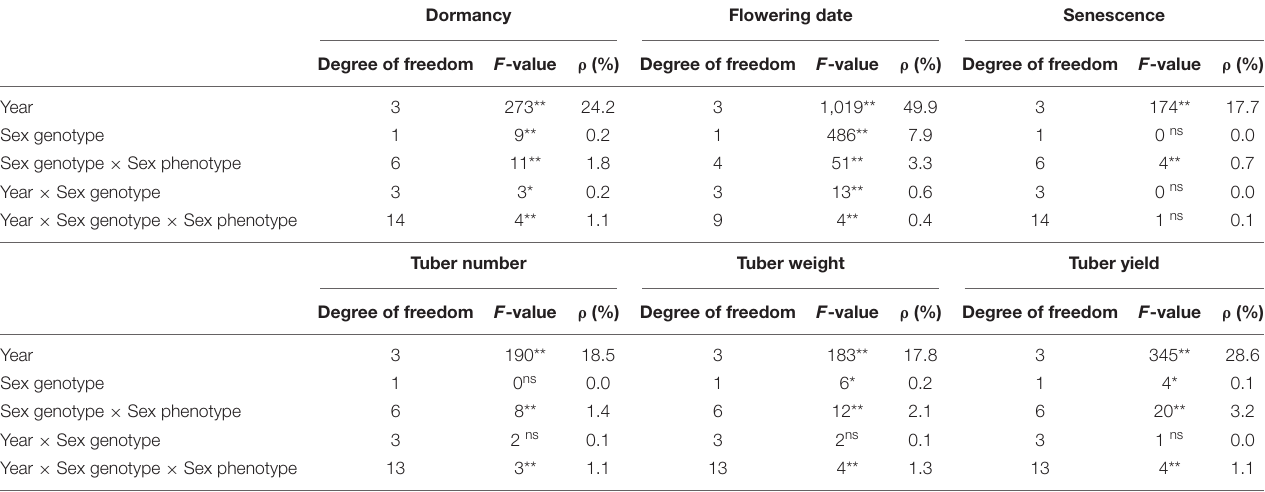
TABLE 1 | F -values and percentage of contribution ( ρ ) of the factors obtained by the nested ANOVA for the variation of agronomic traits. Dormancy Flowering date Senescence